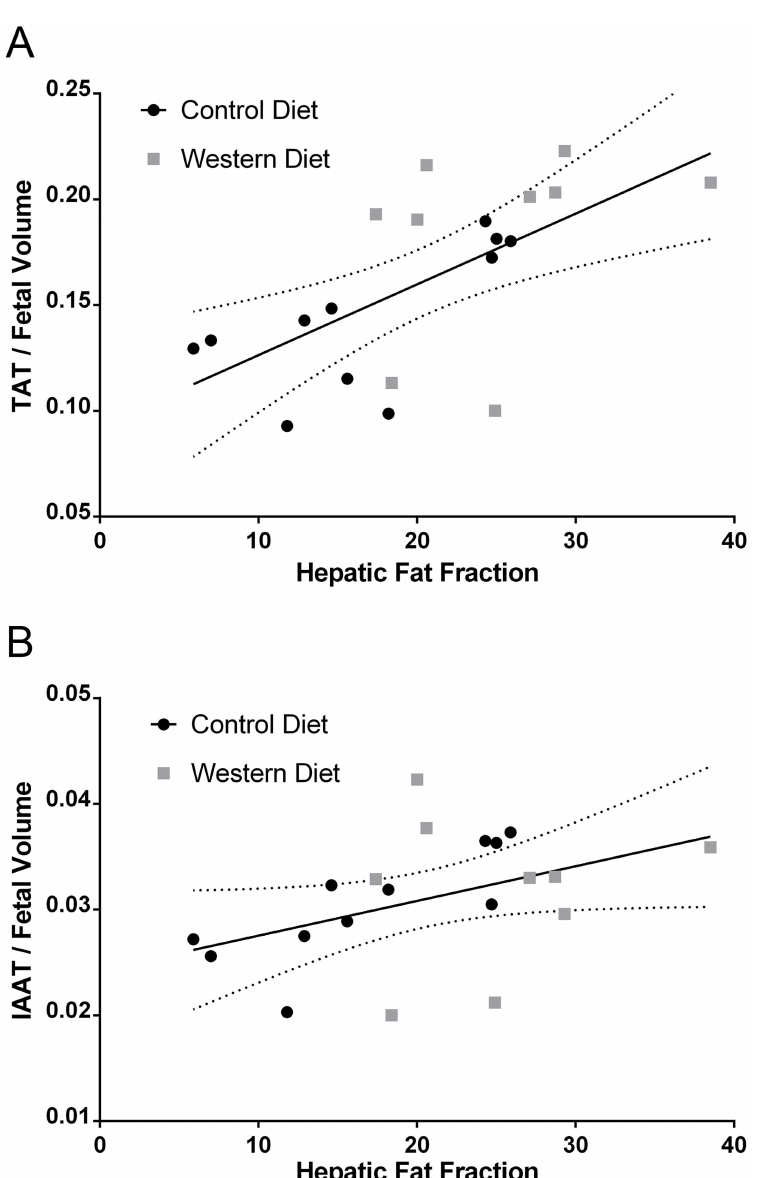
Fig 6. Correlation of fetal adipose tissue volumes with hepatic fat fraction. (A) Total adipose tissue (TAT) to fetal volume ratio as a function of fetal hepatic proton density fat fraction (PDFF). (B) Intra-abdominal adipose tissue (IAAT) to fetal volume ratio as a function of fetal hepatic PDFF. Linear fit lines for all data are shown with 95% confidence intervals.